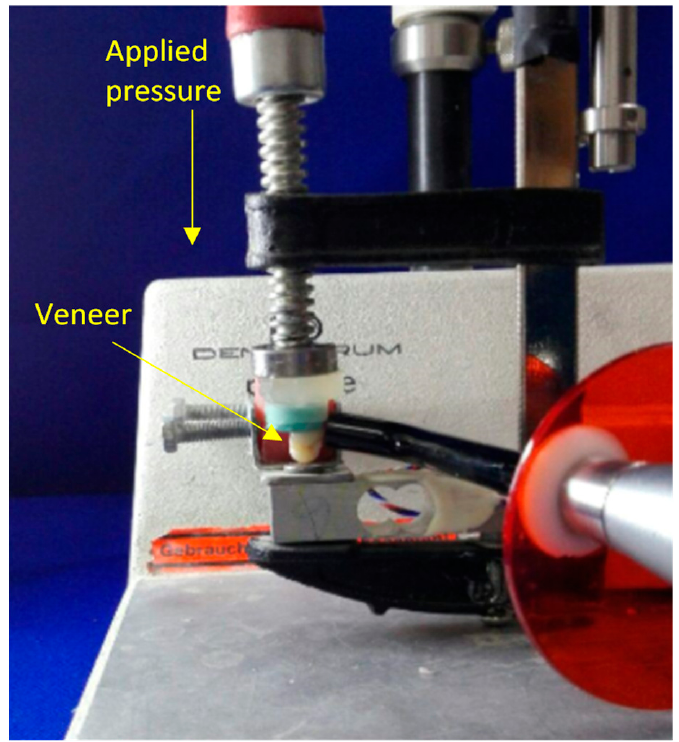
Figure 3. Custom made cementation device.